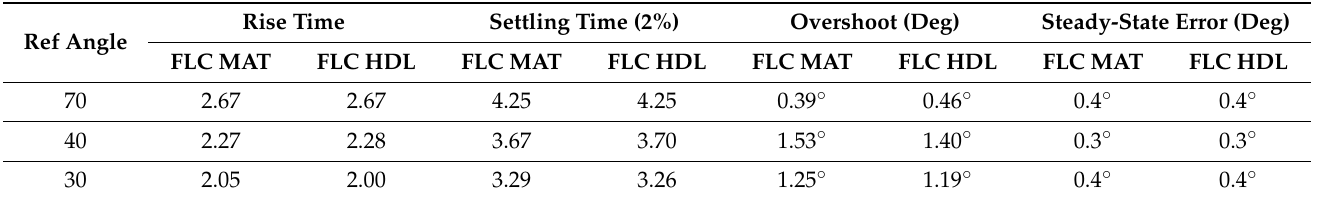
Table 7. Performance of modelled FLC (FLC MAT) and digital FLC (FLC HDL) using the knee extension model in MATLAB